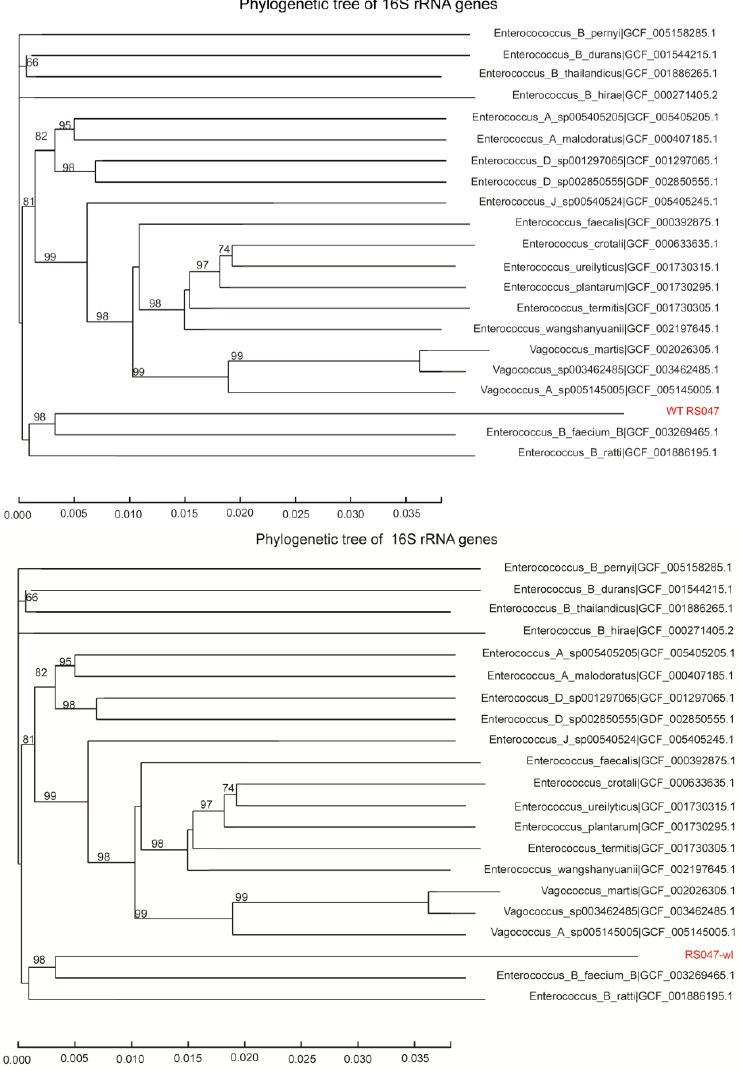
Figure 1. Neighbor-joining tree constructed based on the 16S rRNA sequences in WT RS047 and RS047-wl.